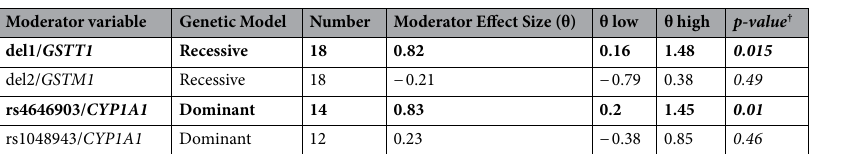
Table 5. The results of the effect modification of variants on lung cancer by smoking status. † p-value <